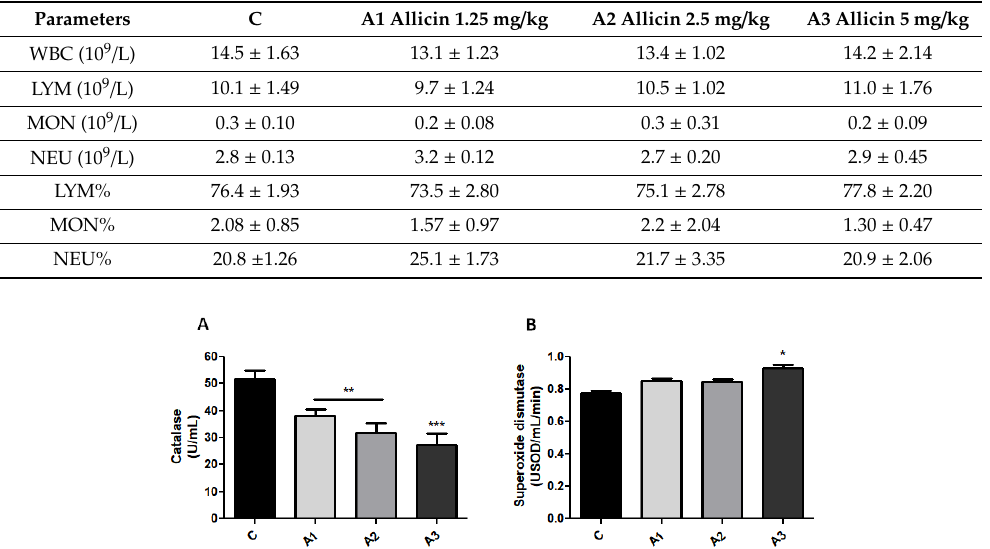
Table 1. Unchanged hematological parameters in the control animals and in the animals treated with allicin. The administration of allicin did not induce significant changes ( p > 0.05) in white blood cell parameters.